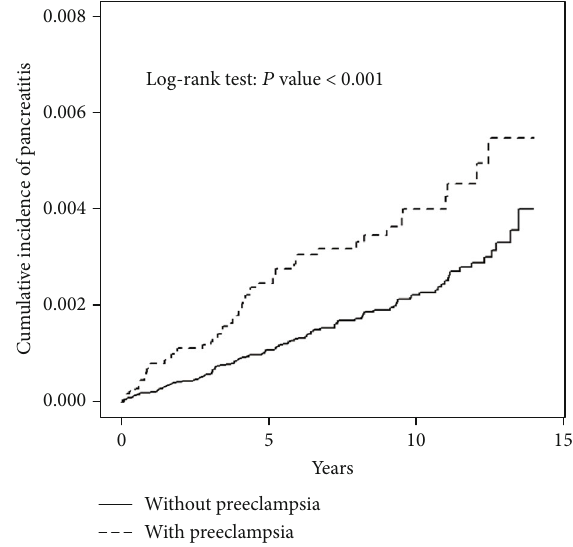
Figure 1: Comparison of cumulative incidence of pancreatitis among patients with preeclampsia and patients in the comparison